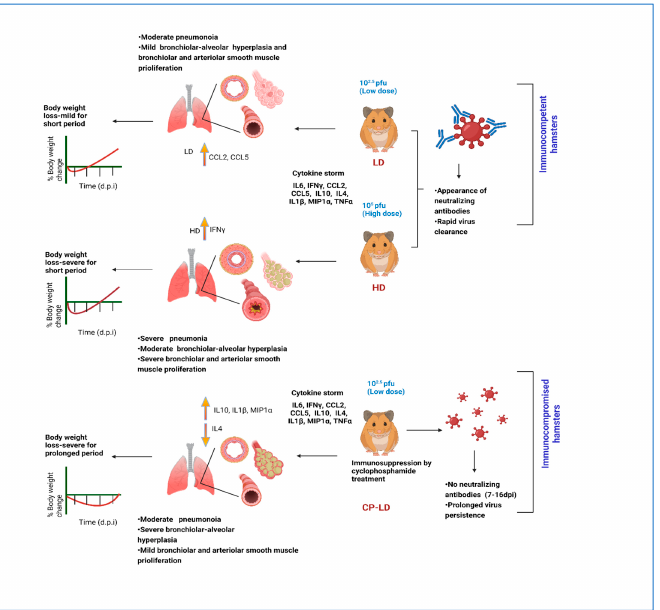
Figure 10. Graphical summary of experimental design and key findings of this study. LD infection of immunocompetent hamsters was associated with mild body weight changes, rapid viral clearance, elevated CCL2 and CCL5 expression, and the presence of neutralizing plasma antibodies. HD infection of immunocompetent hamsters was associated with severe body weight loss and disease pathology, elevated IFN- γ expression, and strong neutralizing antibody in the plasma. In contrast, LD infection of immunocompromised hamsters was associated with less severe but prolonged bodyweight changes, persistent viral load, elevated IL10, IL1b, MIP1A, and dampened IL4 expression. No neutralizing antibodies were detected in the plasma of these animals. LD—low-dose infection; HD—high-dose infection; CP-LD—Cyclophosphamide (immunosuppressed)-treated-low dose infection.